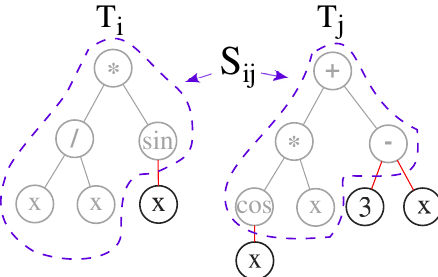
Figure 1. Example of the shared structure S i , j between two trees T i and T j ([2], with permission from